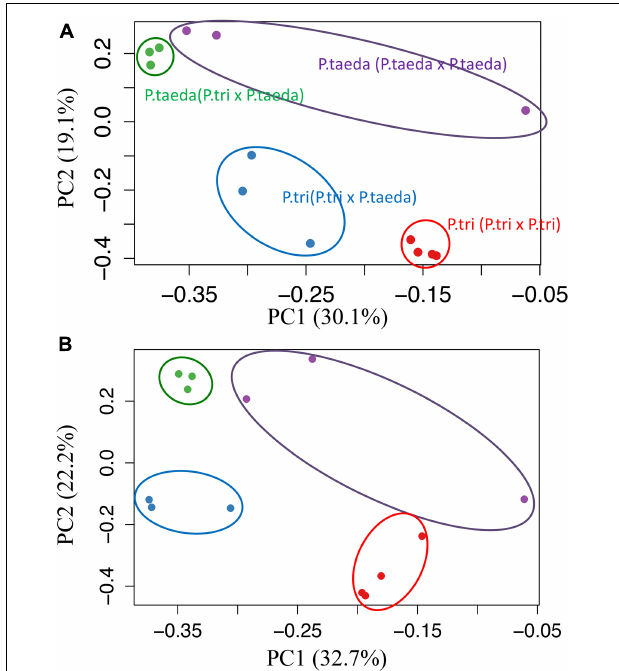
FIGURE 6 | Shifts in gene expression patterns of root microbiomes associated with plant species. The principal component analysis of expression patterns for (A) “FUNGAL GENES originally expressed in Populus trichocarpa root ( FunGene_P. tri )” ( ∼ 482K contigs), and (B) “FUNGAL GENES originally expressed in Pinus taeda root ( FunGene_P. taeda )” ( ∼ 155K contigs). Color-filled circles show loadings of whole gene groups for root samples across different host combinations [ P. trichocarpa ( P. trichocarpa × P. trichocarpa ) in red; P. trichocarpa ( P. trichocarpa × P. taeda ) in Blue; P. taeda ( P. trichocarpa × P. taeda ) in green; P. taeda ( P. taeda × P. taeda ) in purple; n ≥ 3). The distance between points approximates gene expression pattern differences among the samples. The percentage of variances were indicated in the parentheses. Root-microbiome genes were sorted using de novo assembly. Computational workflows for data analyses are shown in Supporting Information Text A2, Supplementary Figures 2, 3 , and Supplementary Dataset 3